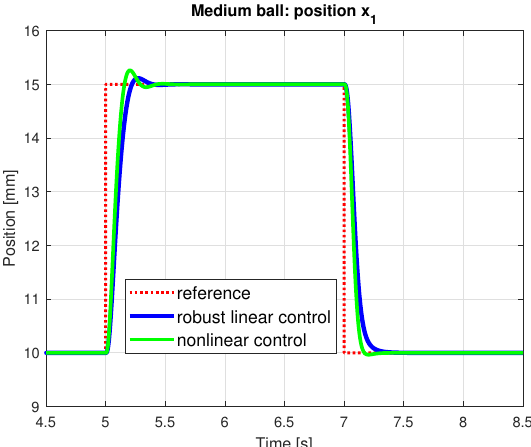
Figure 16. Small ball—control variable u : comparison of simulation results for nonlinear and robust linear pole-placement controllers.